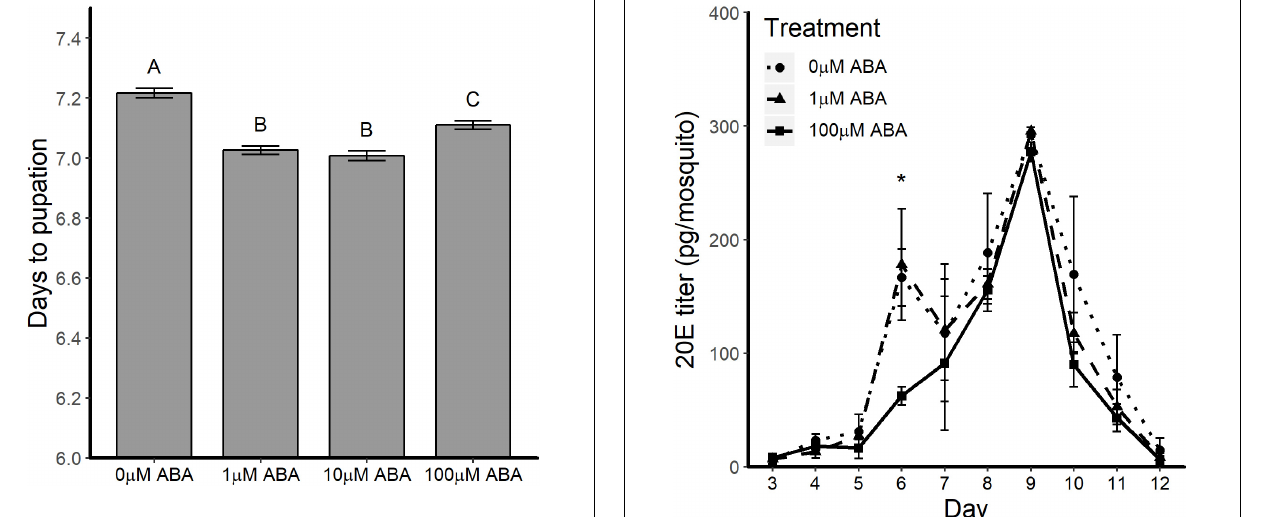
FIGURE 1 | ABA treatment of larval A. stephensi reduced time to pupation. Larvae were exposed to 1, 10 or 100 µ M ABA in rearing water as described in section “Effects of ABA on A. stephensi Larval Development and Pupation.” Time to pupation was reduced at all concentrations of ABA compared to control larvae (ANOVA p < 0.001). Data from five biological replicates were combined for analysis and are shown as mean ± SEM. Different capitalized letters indicate significant differences among controls and treatments. Control = 1456 larvae, 1 µ M ABA = 1403 larvae, 10 µ M ABA = 1382 larvae and 100 µ M ABA = 1287 larvae.